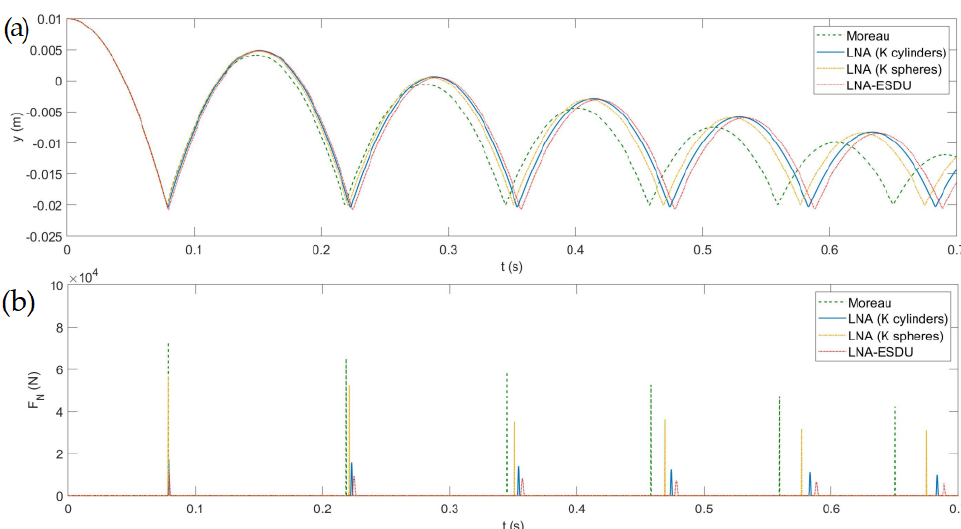
Figure 6. Model comparison considering a central impact: ( a ) y -coordinate of G 1 , ( b ) impact force F N .